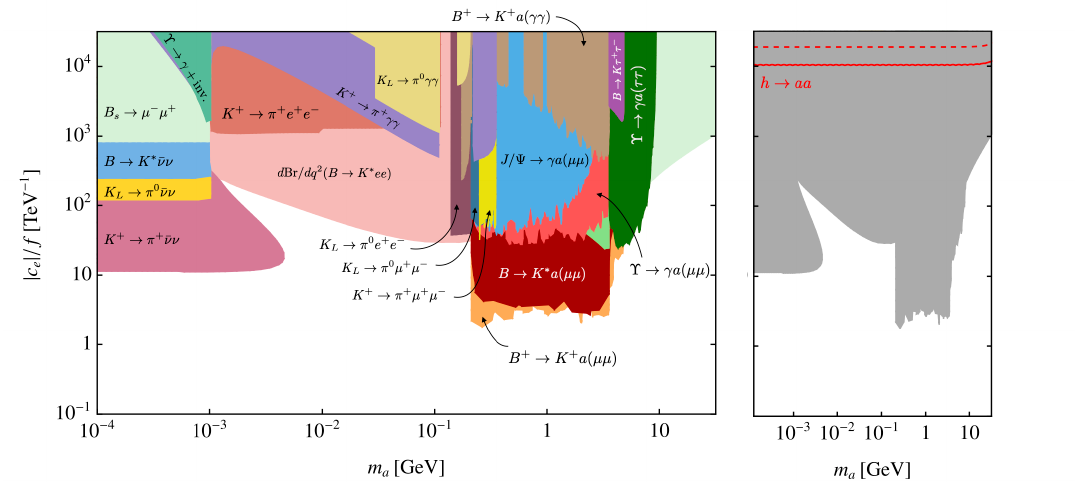
Figure 27 . Left: flavor bounds on universal ALP couplings to lepton doublets with c e = c e 1 , and all other Wilson coefficients zero at the scale Λ = 4 πf and f = 1 TeV. Right: contours of constant Br ( h → aa ) = 10 − 1 and 10 − 2 are depicted as red dashed and solid lines,